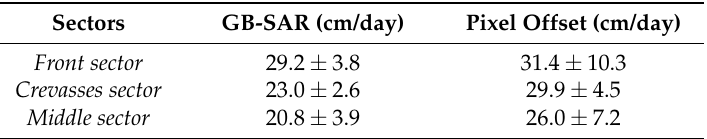
Table 4. Comparison of mean daily velocities between the Pixel Offset method and GB-SAR. The acquisition time refers to the period from 4 September 2015 to 27 September 2015. The error is given as the standard